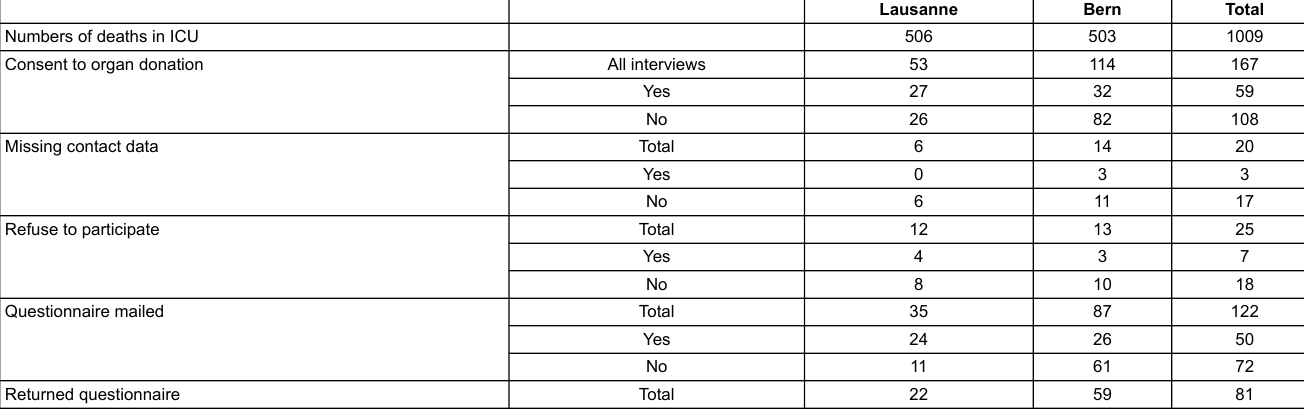
Table 1: Characteristics and numbers of the interviews with next of kin regarding consent/refusal of organ